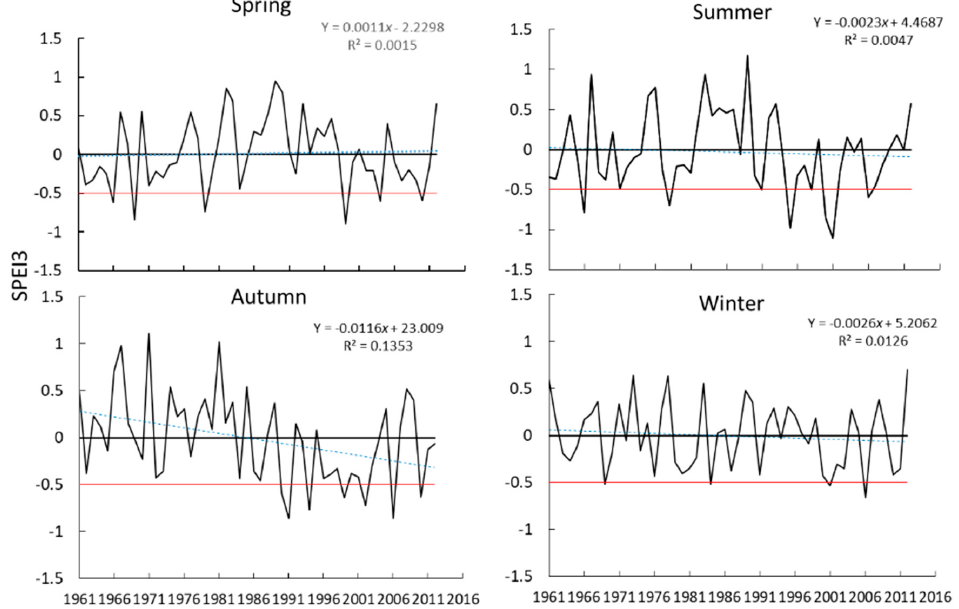
Figure 4. Dynamic characteristics of SPEI for different seasons in Qinghai Province.